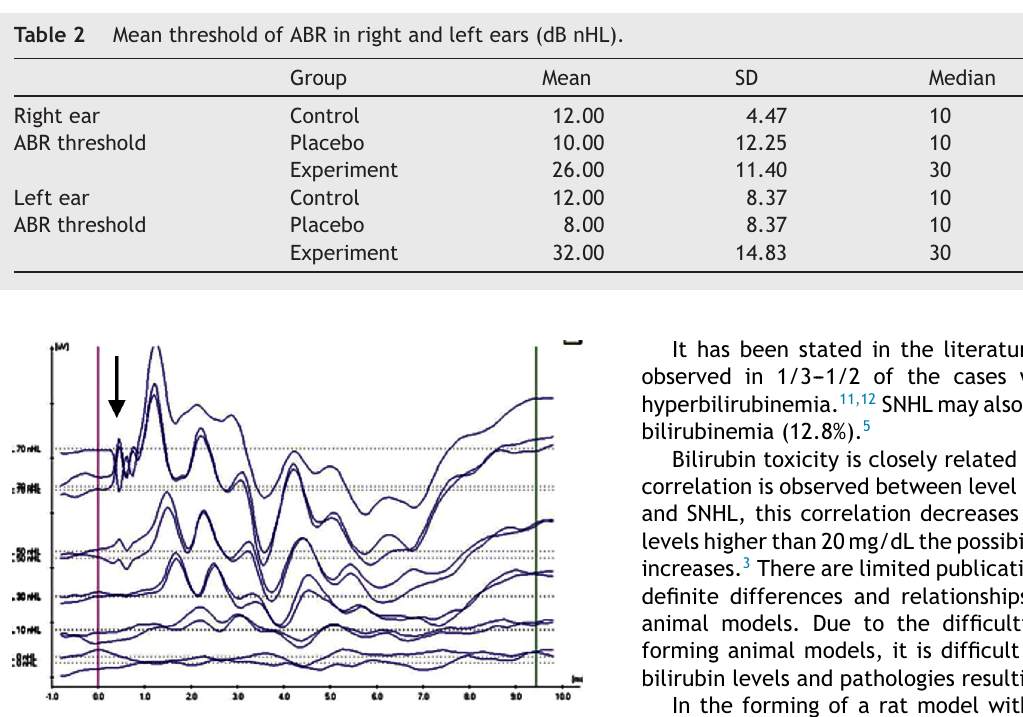
Example for Category 3 (normal ABR with Cochlear Microphonic).